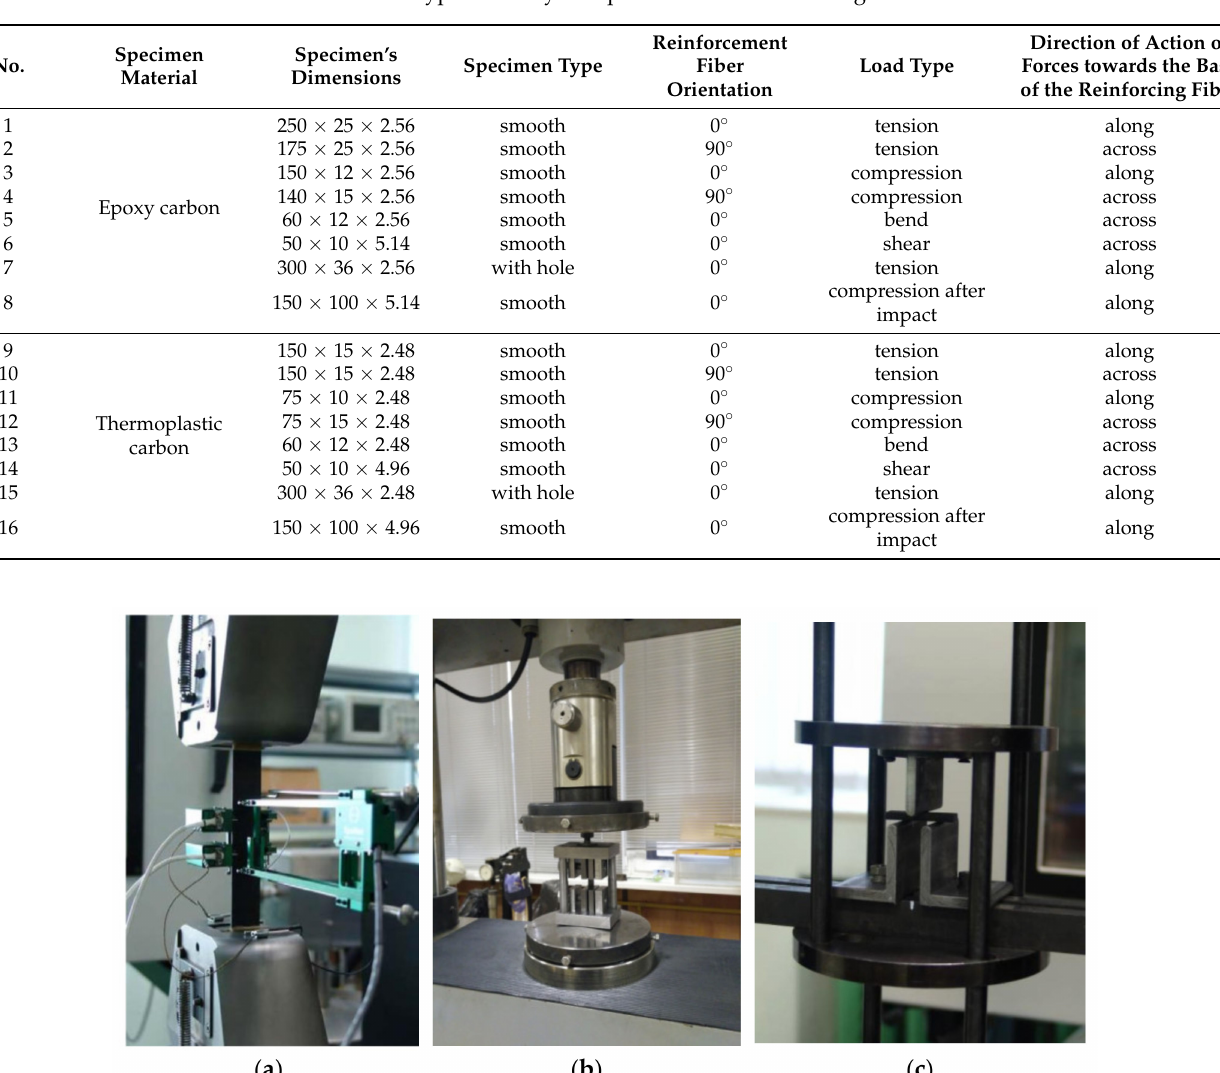
Table 2. Types of analyzed specimens and test loadings.